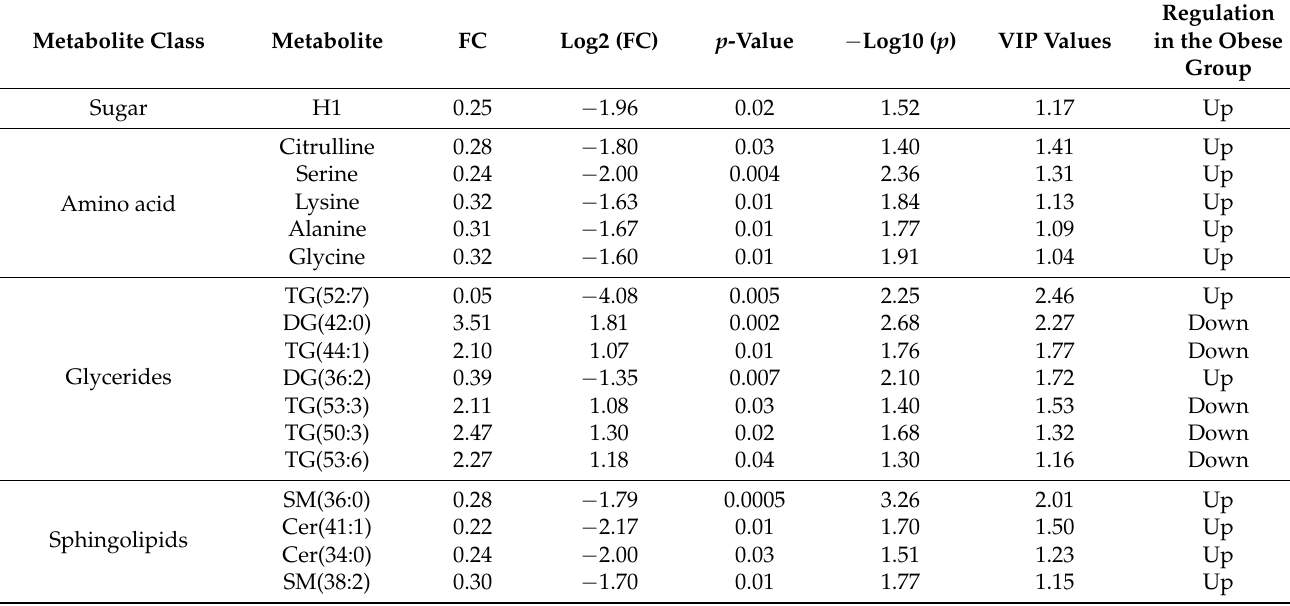
Figure 2. Partial least square-discriminant analysis (PLS–DA), showing a robust separation among the groups (control vs. obese). Each point in the plot corresponds to a saliva sample. After multivariate statistics, the Student’s t -test and FC analysis were applied and depicted in a Volcano plot (Figure 4). This analysis highlighted 27 metabolites, including one sugar, five amino acids, seven glycerides, four sphingolipids, eight glycerophospho- lipids, and two acylcarnitines (ACs). A complete description of the significant metabolites identified is included in Table 1. Table 1. Volcano plot data comparing obese versus control dogs. VIP values were obtained from a multivariate analysis using the PLS–DA